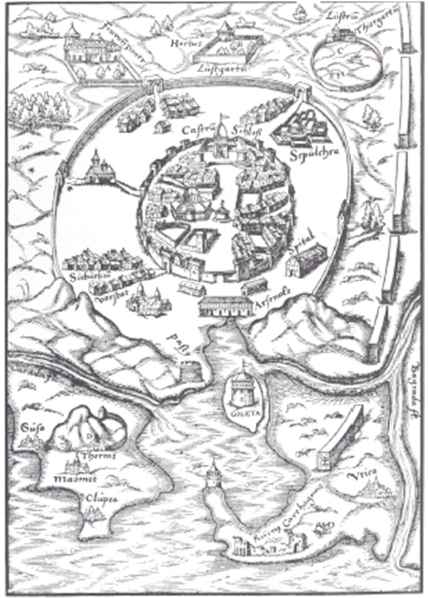
Figure 2. Tunis city from an engraving German of a book not identified from the 17th (data source: Abdelkafi, J. La médina de Tunis, espace historique ; Presses du CNRS: Paris, 1989).